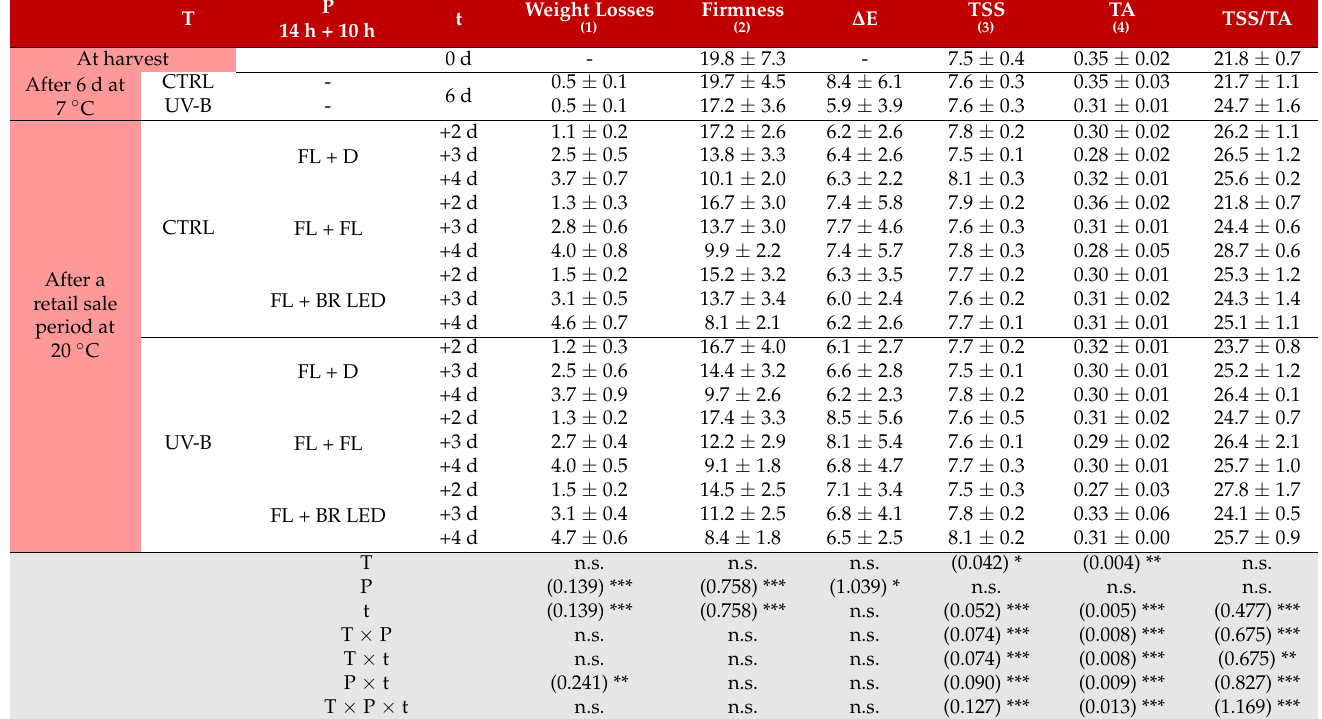
Table 2. Physicochemical quality attributes of UV-B-treated and untreated CTRL bell peppers after 6 d at 7 ◦ C followed by a retail sale period of 2, 3, and 4 d at 20 ◦ C under a photoperiod of 14 h in fluorescent light + 10 h in different lighting